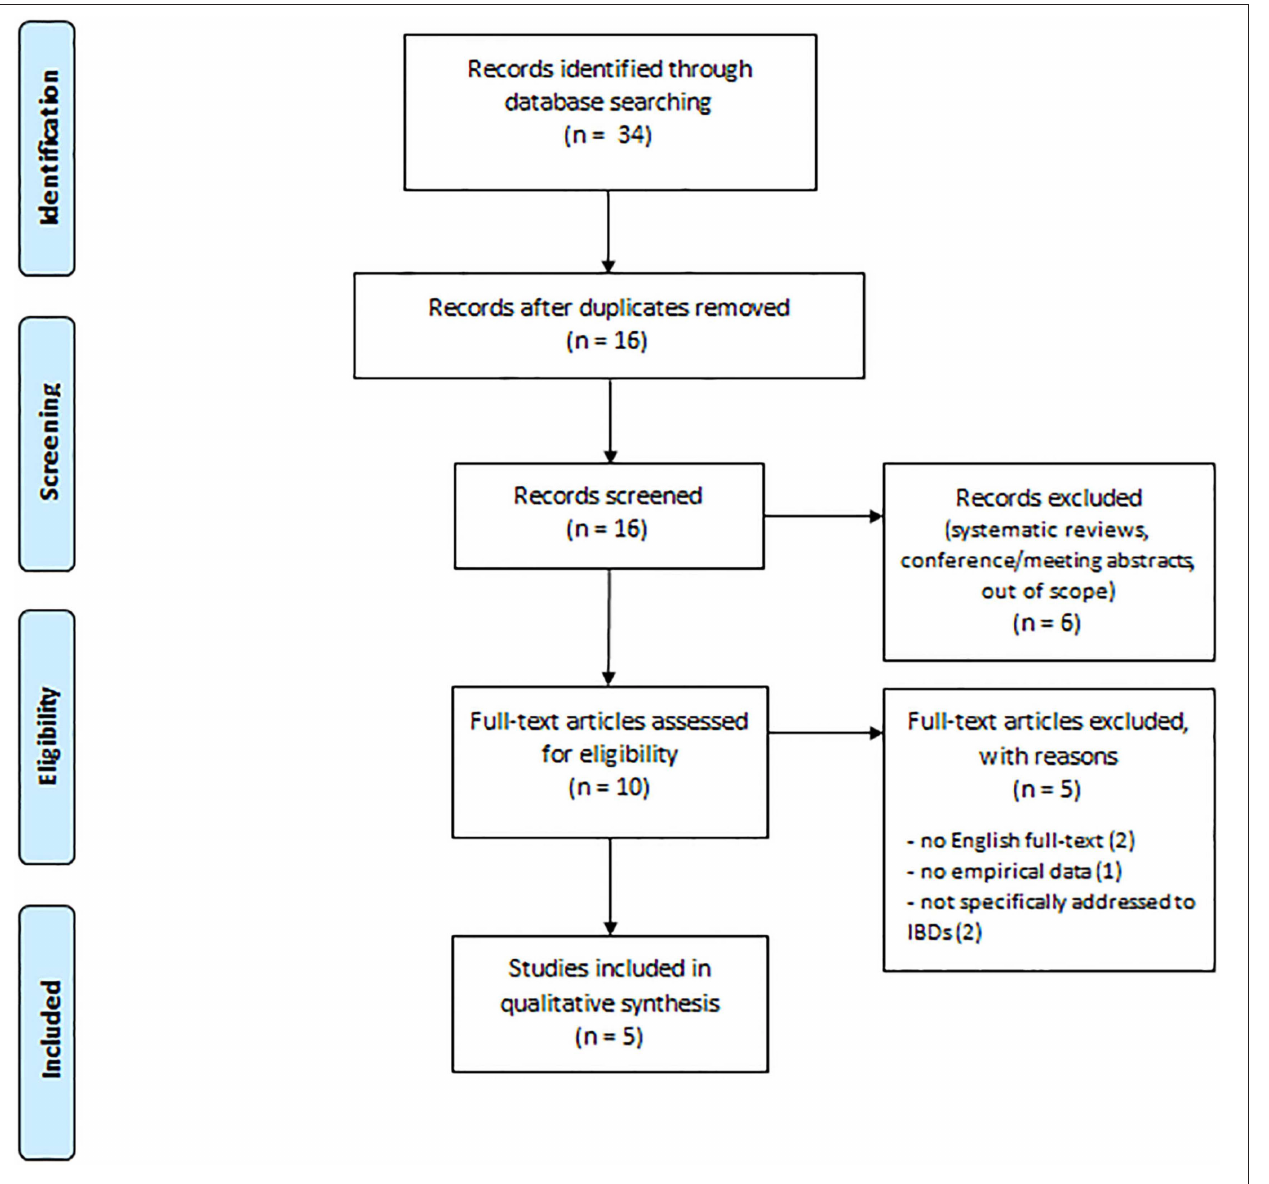
FIGURE 1 | Preferred reporting items for systematic reviews and meta-analyses (PRISMA) flow